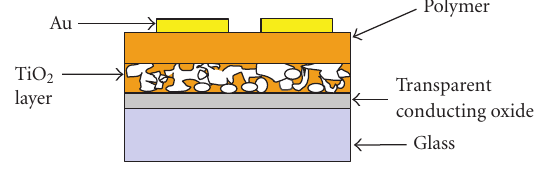
Figure 1: Bilayer heterojunction solar cell.